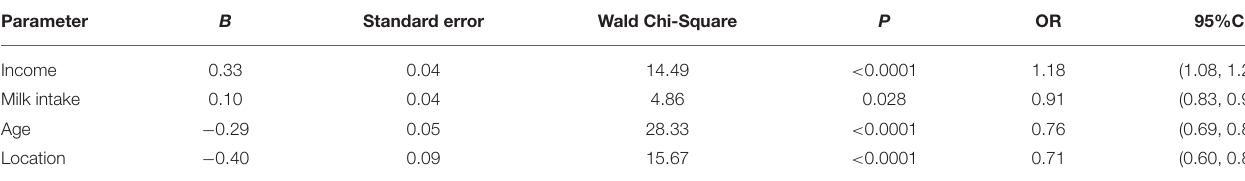
TABLE 3 | Multiple stepwise regression analysis of the VA level ( n =